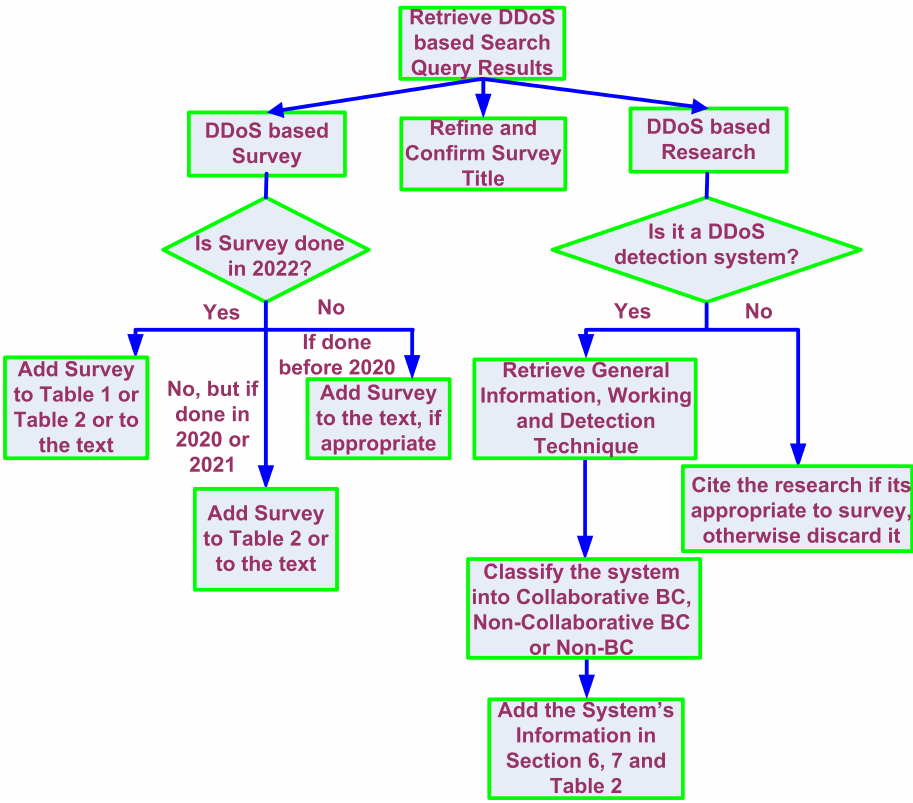
Figure 1. Flowchart for Data (i.e., Paper)